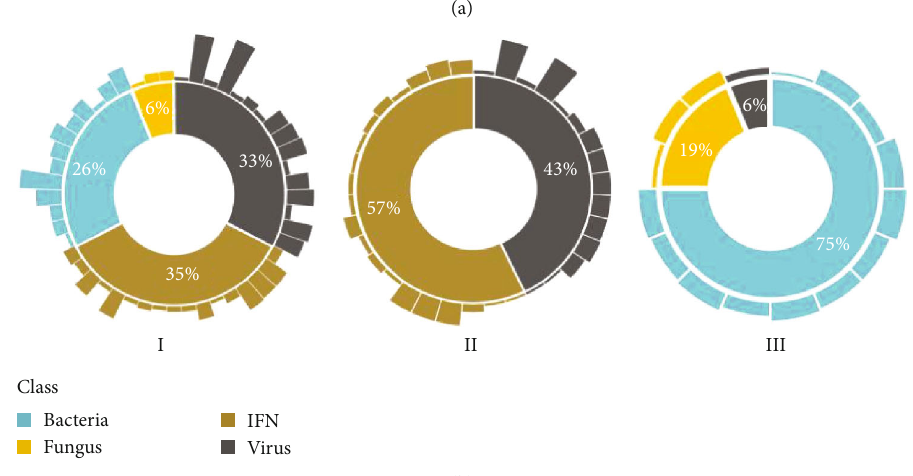
Figure 3: (a) Analysis of subtypes in functional modules. The function of disorders was divided into fi ve modules: viral infection, bacterial infection, fungal infection, IFN disorder, and immune disorder. Each group of entries in the module represents BPs (biological processes), the height of the bars represents the degree of dysfunction, and the higher it is, the more serious the dysfunction. (b) Analysis of functional modules in subtypes. The middle circle represents the proportion of dysregulated functions in subtype, outer bars represent dysregulated functions, and the height of the bars represents the degree of